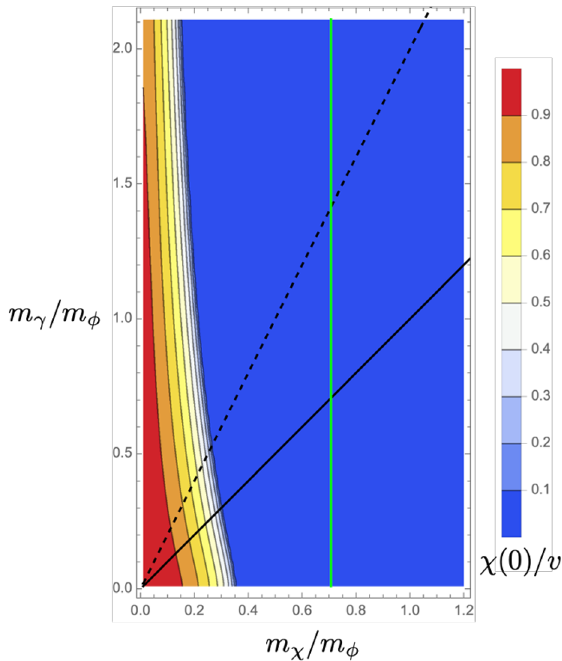
Figure 14 . The phase diagram of the single vortex. The vortex is of the Abelian type in the blue region, otherwise it is of the non-Abelian type. The solid line m γ = m χ is the analytic estimation of the phase boundary between type I*A (above) and type II (below) non-Abelian vortices, whereas the dashed line m γ = 2 m χ corresponds to the analytic estimation of the boundary between type I*A (below) and type I*B (above), see discussion around table